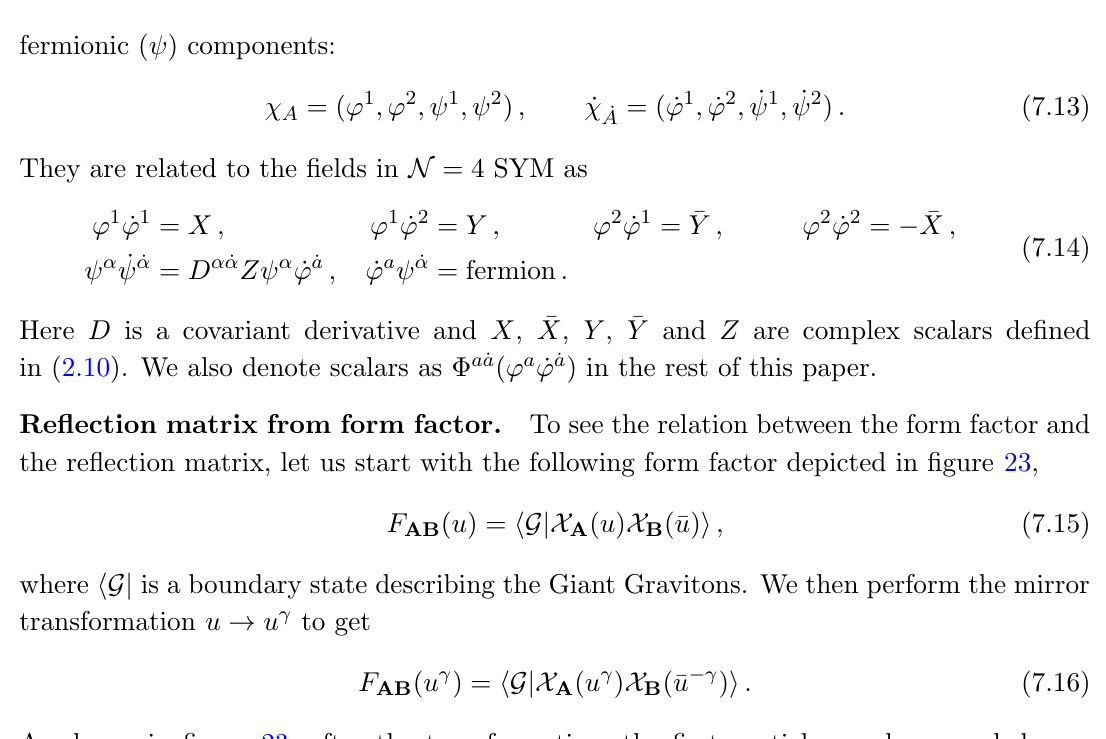
Figure 23 . The relation between the form factor and the re(cid:13)ection matrix. After the mirror transformation, the particle with rapidity u moves to the left edge while the particle with rapidity (cid:22) u moves to the right edge. If we further perform the charge conjugation (and rotate the whole picture by 90 degrees), we end up with a standard re(cid:13)ection